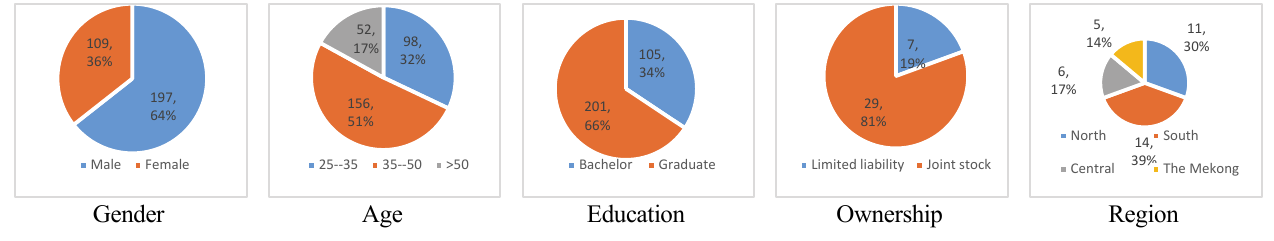
Fig. 2. Description of demographic characteristics of the surveyed